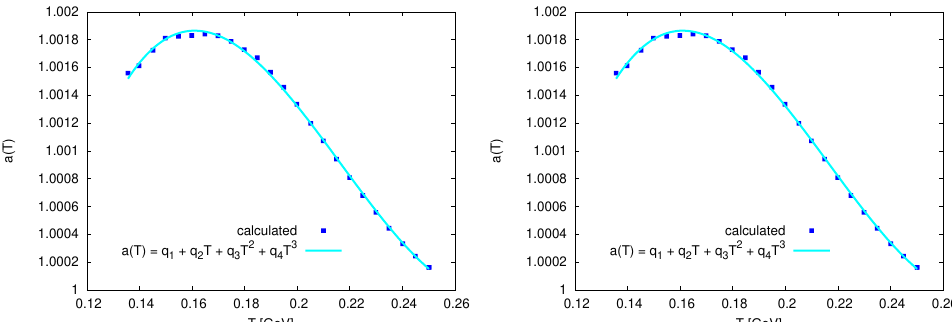
Figure 10. The left panel shows the time evolution of the scale factor during the quark-hadron phase transition, at bag constant B 1/4 = 200 MeV. The solid curve presents our fit to Equation (29). The right panel depicts the scale factor as a function of T , Equation (30), while solid curve presents Equation